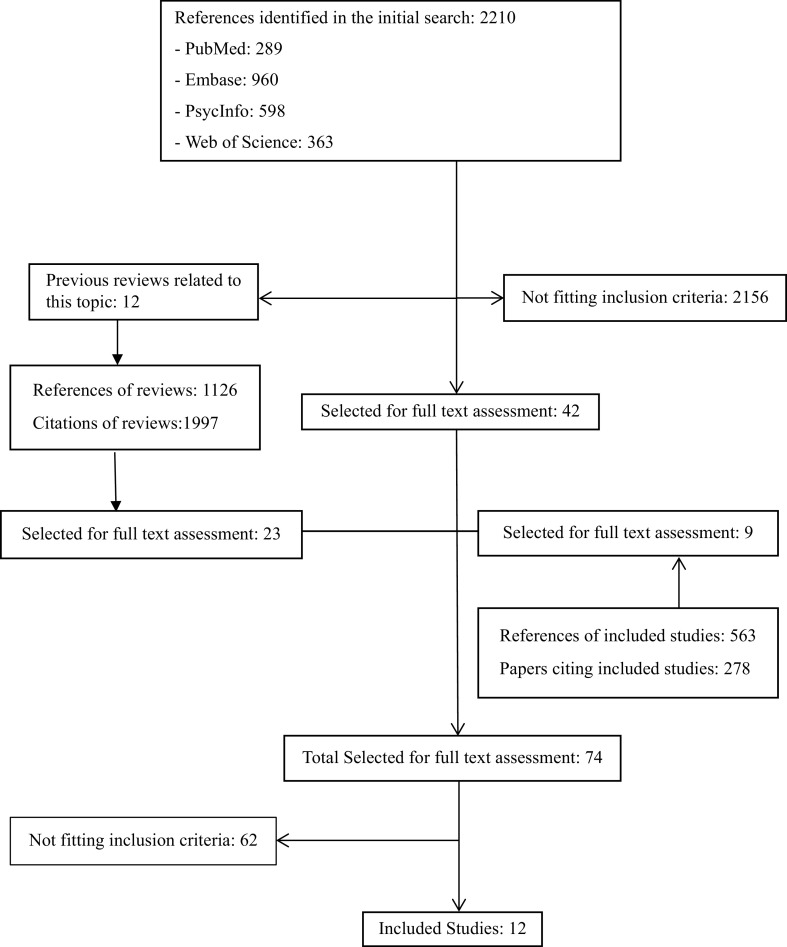
Results of literature search.